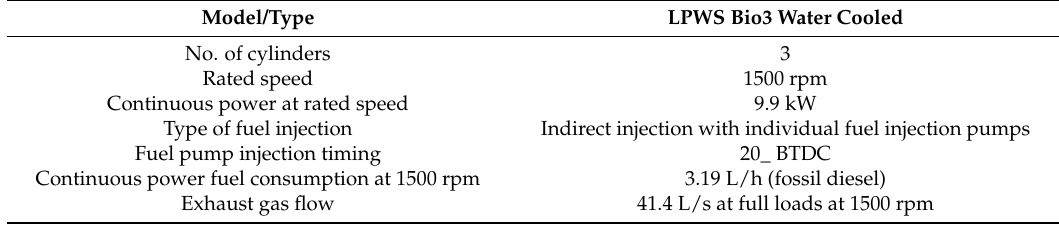
Table 1. Specifications of the engine used in the experiment.